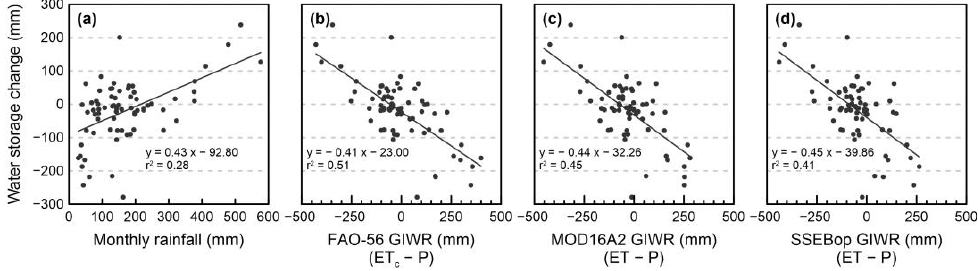
Figure 7. Correlations across precipitation, the gross irrigation water requirement, and water storage changes: correlation between water storage change and monthly rainfall ( a ) and correlations between monthly water storage change and GIWR (GIWR (positive value) and rechargeable rainfall (negative value) when the aquifer is not full) of FAO-56-based ( b ), MOD16A2 based ( c ), and SSEBop-based ( d ) values. On the y-axis, negative values refer to declines in groundwater storage, while positive values refer to groundwater